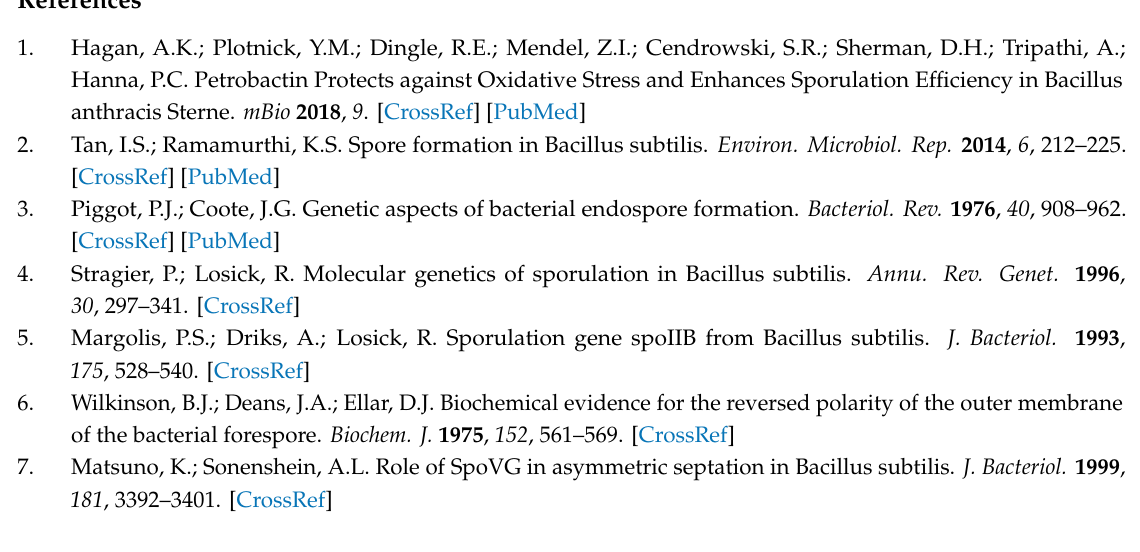
Figure S1: Verification of di ff erentially expressed genes using RT-qPCR; Figure S2: E ff ect of SpoVG on growth. Table S1: Primer sequences; Table S2: List of all di ff erentially-expressed proteins identified via iTRAQ analysis; Table S3: List of di ff erentially-expressed proteins related to growth and spore formation; Table S4: Conservation of comC between B. anthracis and B. subtilis